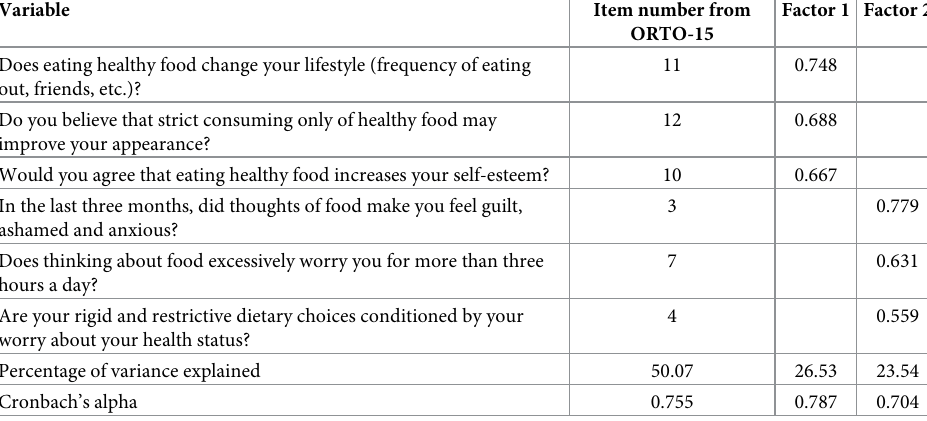
Table 2. Factor analysis of the ORTO-R scale items using the varimax rotation among Lebanese sample.